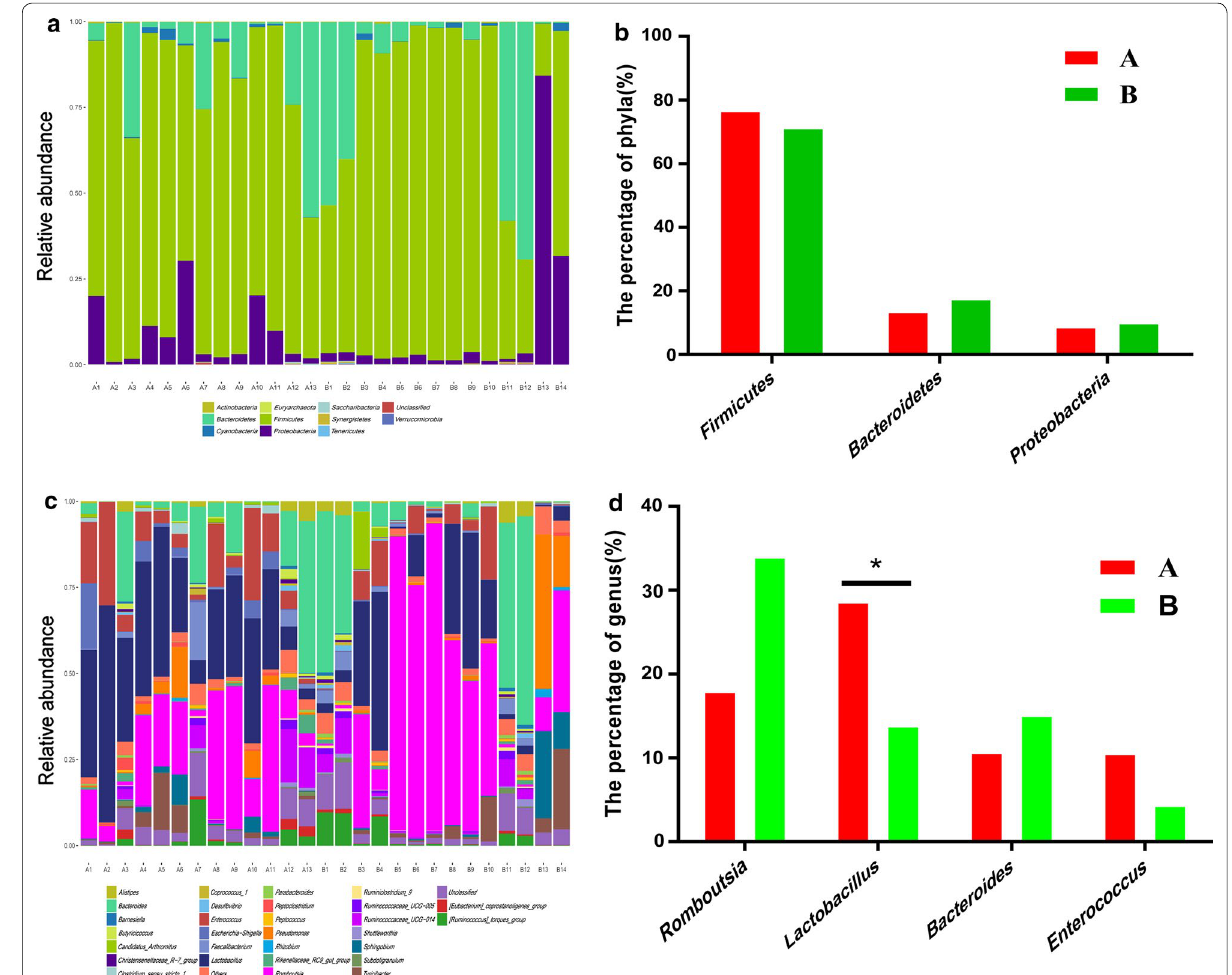
Fig. 4 Phylum-level and genus-level analyses of the 27 samples. a Overall fecal microbiota composition of the samples at the phylum level in groups A and B. b Comparison of the relative abundances of the three main bacterial phyla in groups A and B. c Overall fecal microbiota composi- tion of the samples at the genus level in groups A and B. d Comparison of the relative abundances of the four main bacterial genus in groups A and B. The relative abundances of Romboutsia , Lactobacillus , Bacteroides , and Enterococcus are shown on the y -axis. Boxes with one asterisk indicate significant differences between the two groups at p < 0.05 using a t